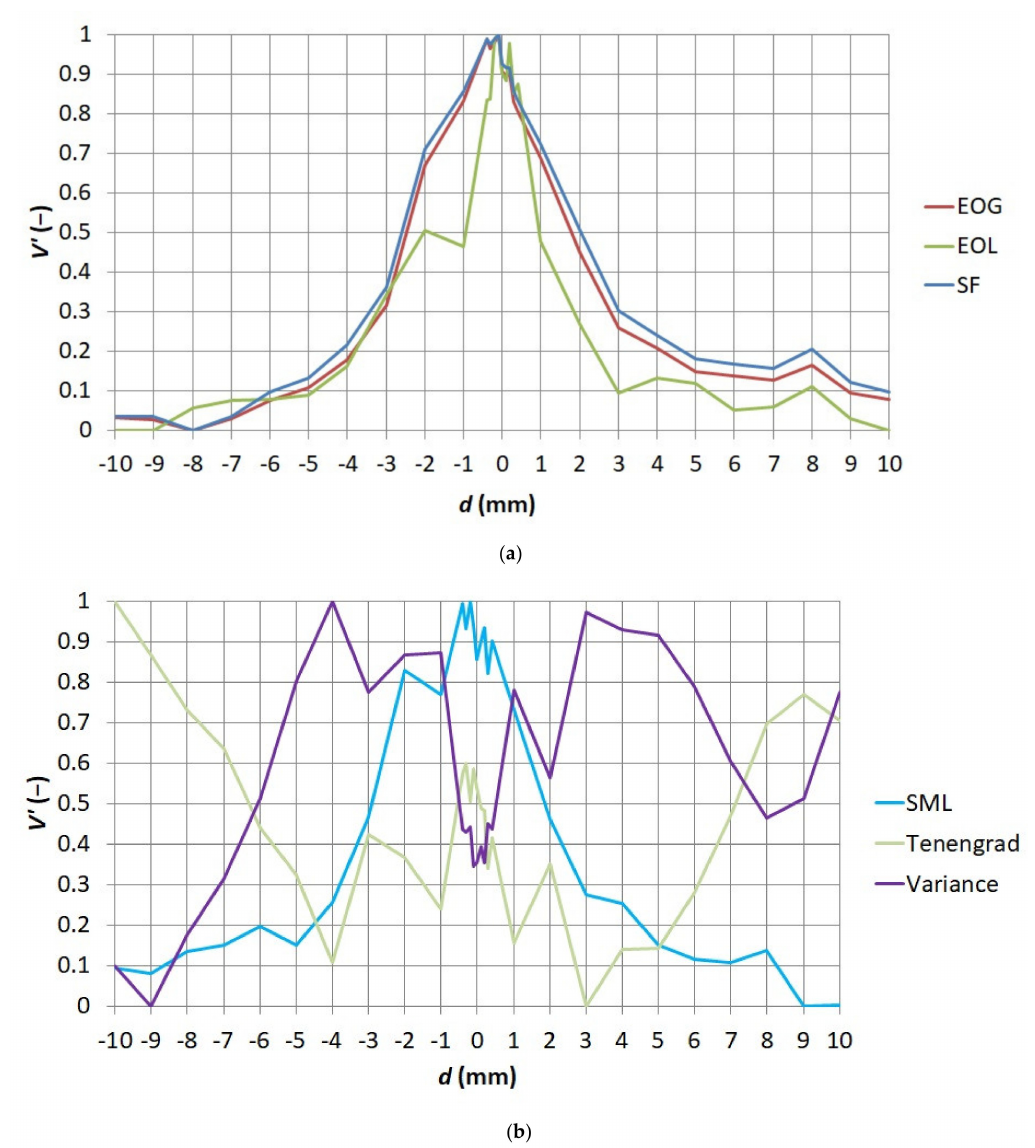
Figure 6. Relationship between the standardized value of sharpness measures V (cid:48) and the distance between the thermo- graphic camera lens and observed object d for the first series of thermograms ( a ) EOL, EOG, and SF ( b ) SML, Tenengrad, and